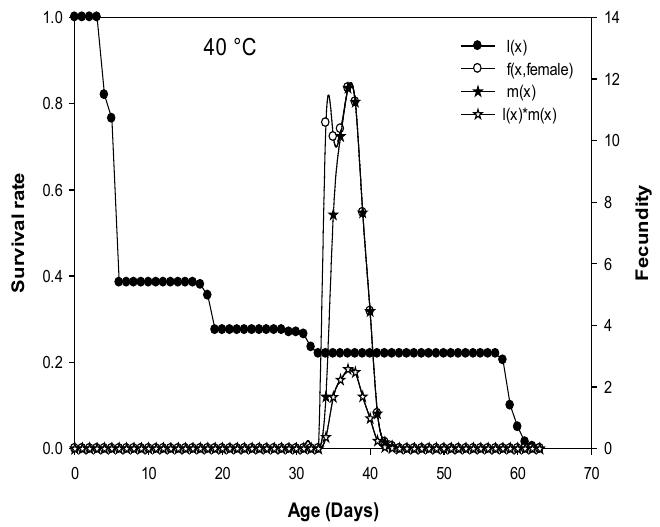
Figure 2. Age-specific survival rate (l x ), age-stage fecundity of female (f x ) (eggs/female), age-specific fertility (m x ) (=born nymphs/female), and age-specific maternity (l x m x ) of D. opuntiae fed on O. ficus- indica at five different constant temperatures.